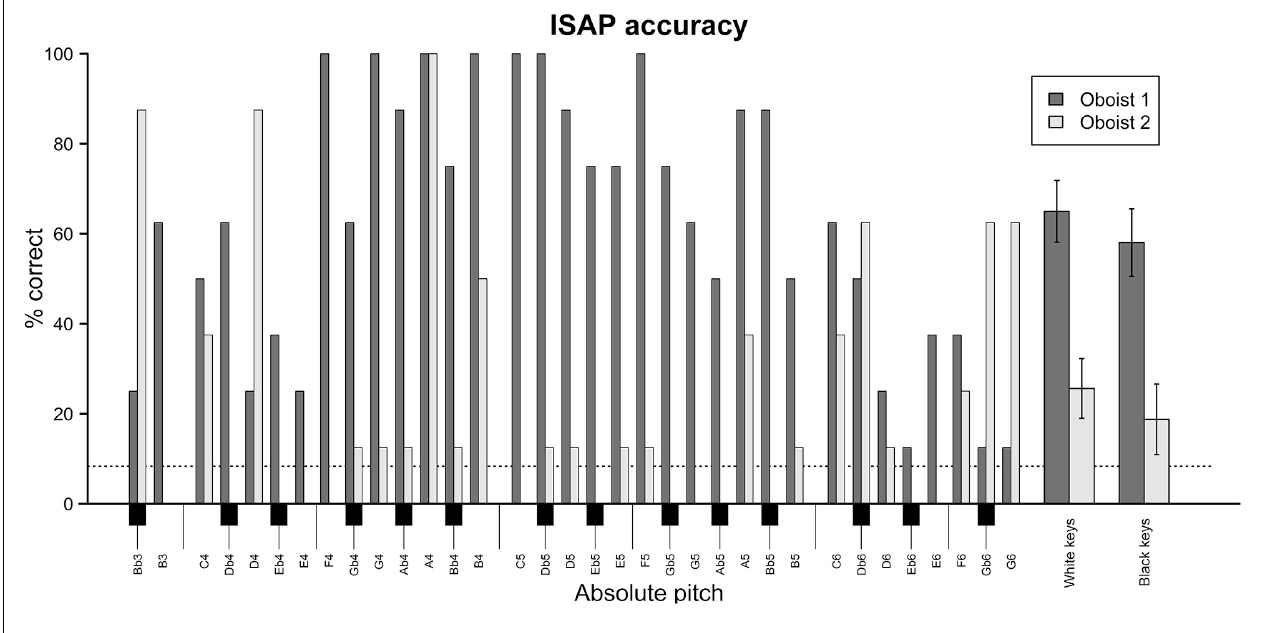
FIGURE 6 | Bar plot indicating proportion of correct pitch identification responses (i.e., instrument-specific absolute pitch accuracy) for untransposed oboe tones separate for each of the two oboists and separate for each pitch level spanning the full range of the oboe from B (cid:91) 3 to G6. Although only one enharmonic option occurs for each pitch level on the x-axis, response options included two enharmonic equivalents for each of the “black keys” (e.g., “C#4/D (cid:91) 4” rather than merely “D (cid:91) 4”). The bars on the far right depict proportion of correct responses for pitch categories corresponding to “white keys” (i.e., C, D, E, F, G, A, B) and “black keys” (C#/D (cid:91) , D#/E (cid:91) , F#/G (cid:91) , G#/A (cid:91) , A#/B (cid:91) ) on the piano. Error bars represent standard errors of the